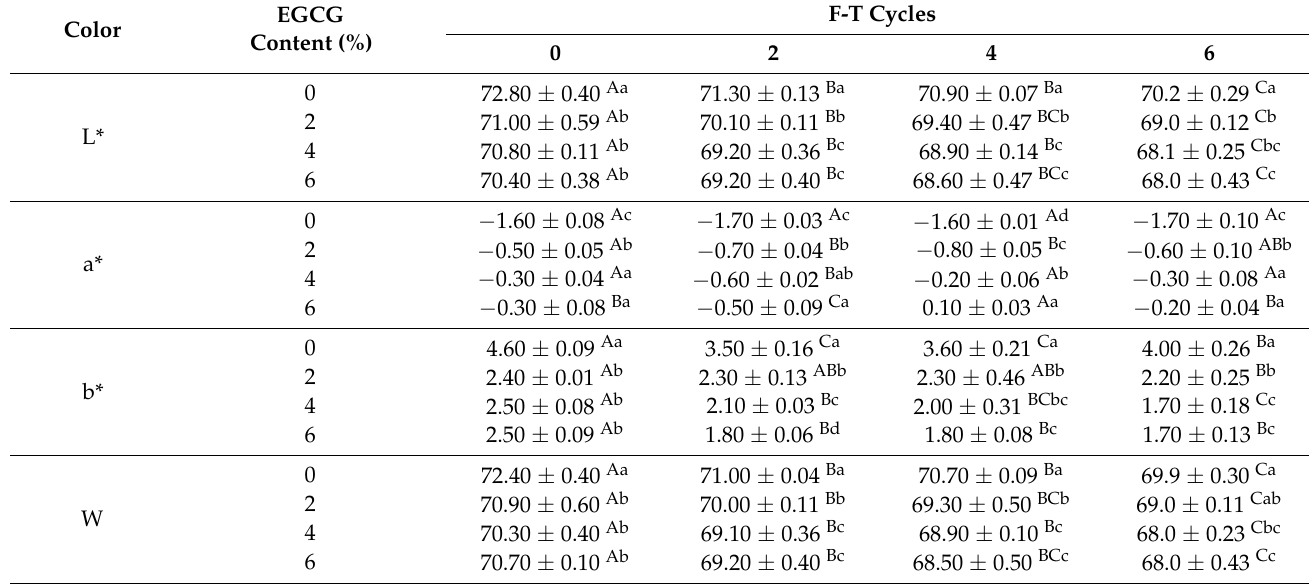
Table 1. Changes in whiteness of surimi gels with difference content EGCG during F-T